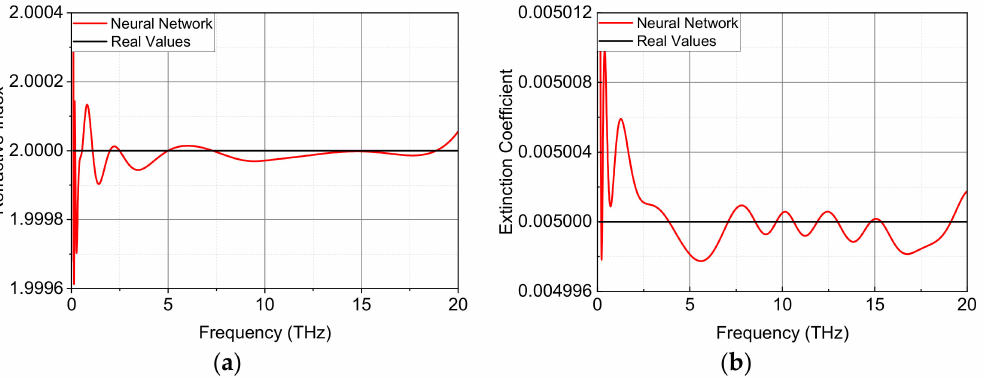
Figure 3. Comparison of extracted optical constants from neural network method and real values for a simulated non-dispersive material ( n = 2 and k = 0.005) with a thickness of 3 mm: ( a ) Refractive index n ; and ( b ) Extinction coefficient k.